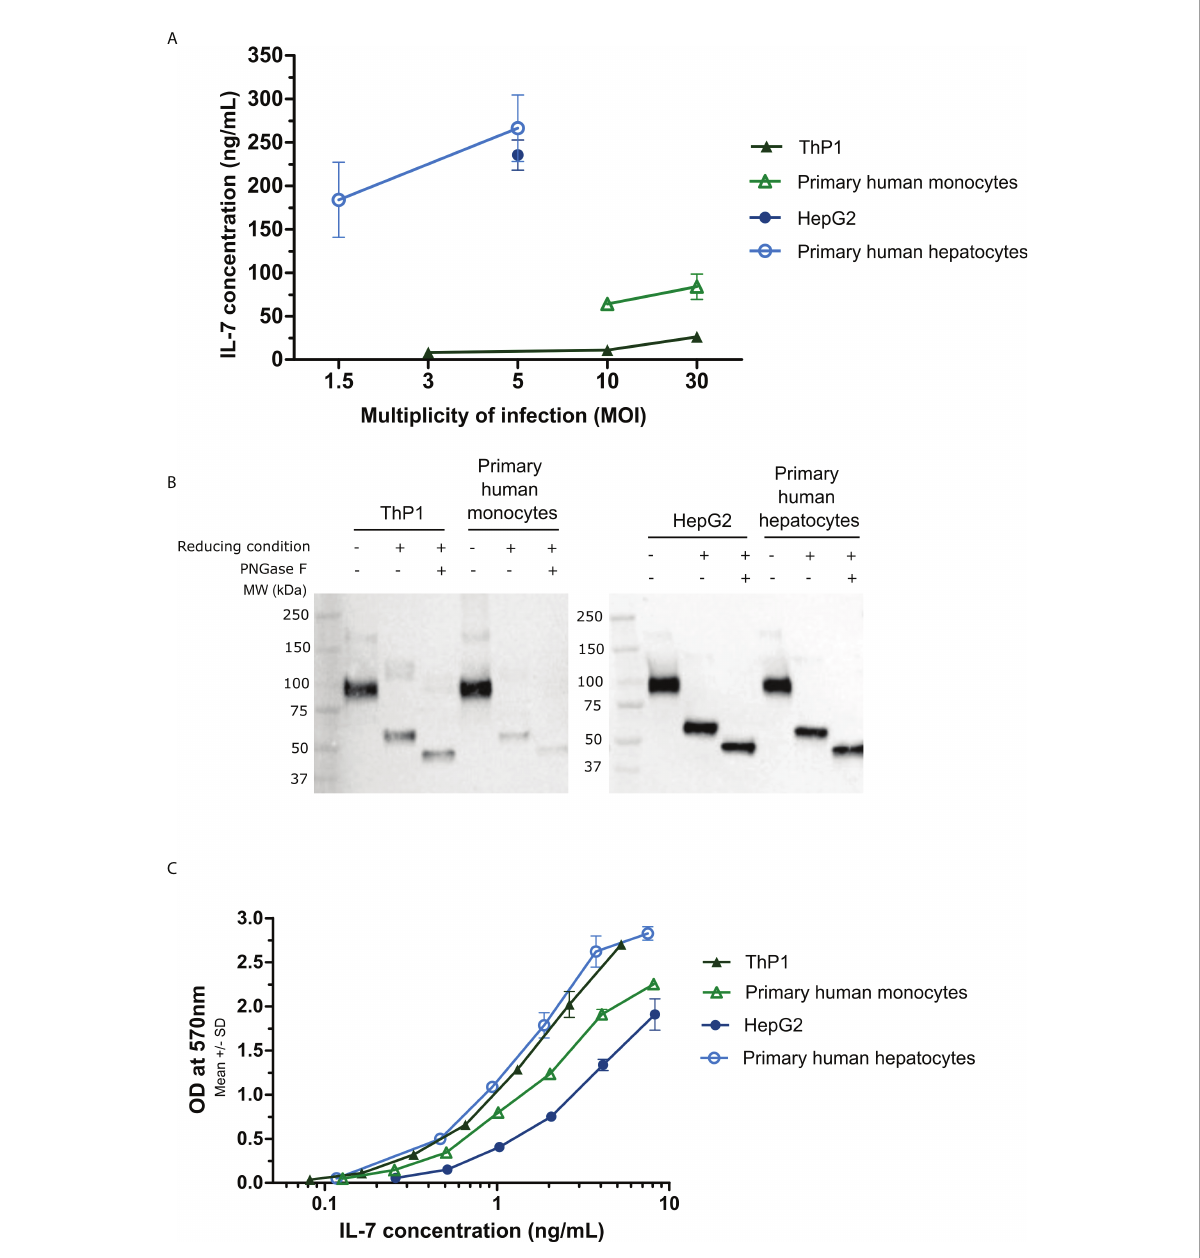
FIGURE 1 Quanti fi cation, biological activity, and Western blot analysis of the MVA-secreted hIL-7-Fc in cell supernatants following in vitro infection with the MVA-hIL-7-Fc. Primary human hepatocytes, HepG2 cells, primary human monocytes, and ThP1 cells were infected in vitro by the MVA-hIL- 7-Fc (M-hIL-7-Fc) or empty MVA (M-empty) and culture supernatants harvested at 24 (h) (A) ELISA quanti fi cation of hIL-7-Fc. Different multiplicities of infection (MOI) of the MVAs were used depending on the cells infected. The detection range of the standard was detected between 7.18 and 500 pg/ml. (B) Western blot analysis of the MVA-produced hIL-7-Fc following PNGase treatment (N-glycosylation analysis) and under reducing condition (dimerization analysis). (C) The biological activity of hIL-7-Fc was evaluated using serial dilutions of supernatants containing hIL-7-Fc on pre-B cell line PB-1. Data are represented as means ± standard deviations of biological